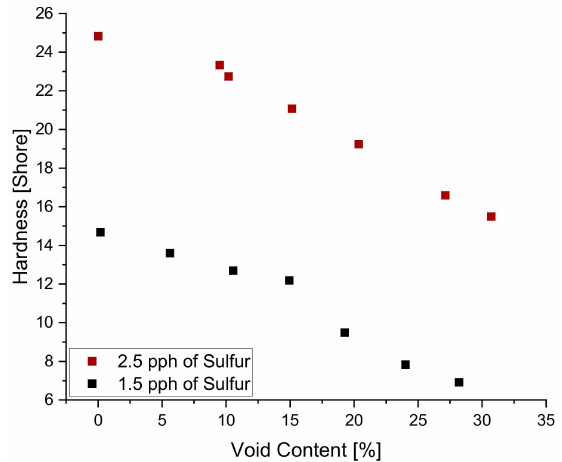
Figure 19. The influence of sulfur content and void content on